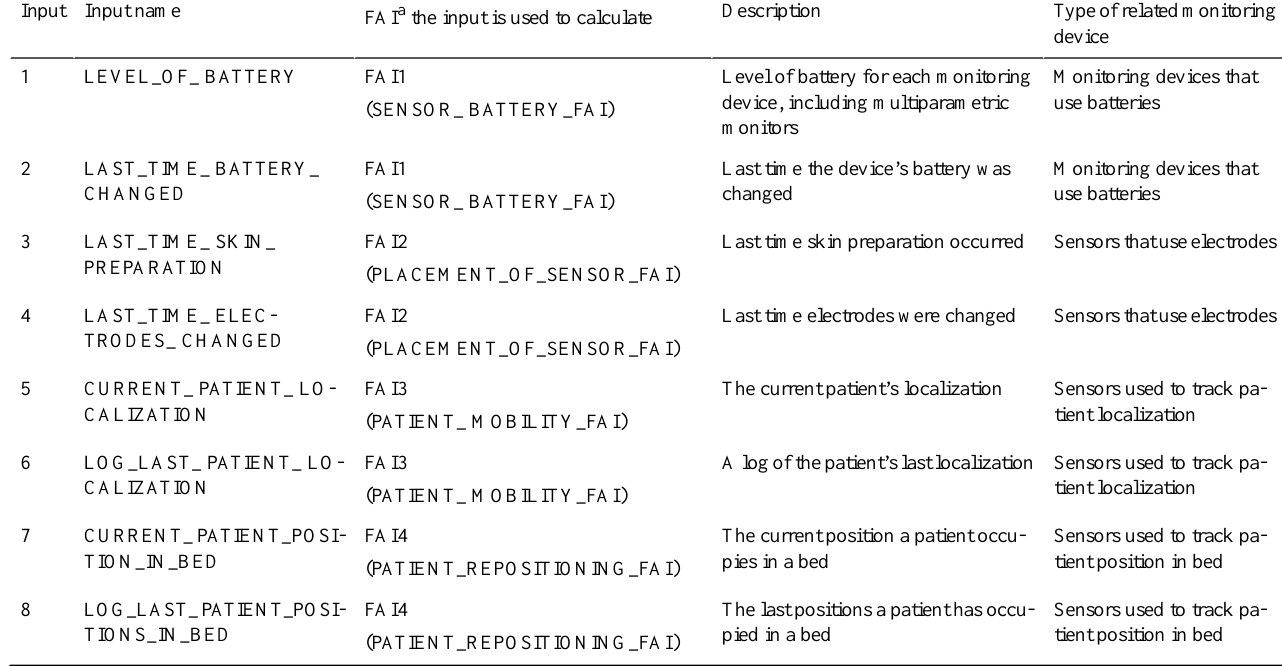
Table 2. Inputs for our reasoning